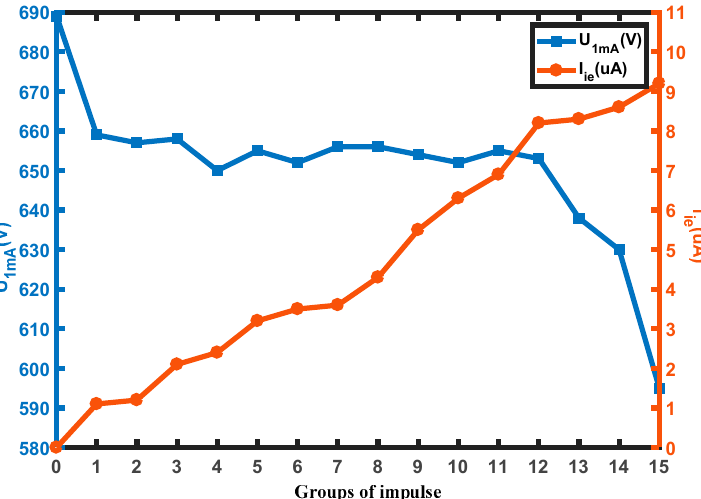
Figure 6. Varistor voltage U 1mA and leakage current I ie variation diagrams of the ZnO varistors under multiple lightning impulse currents.